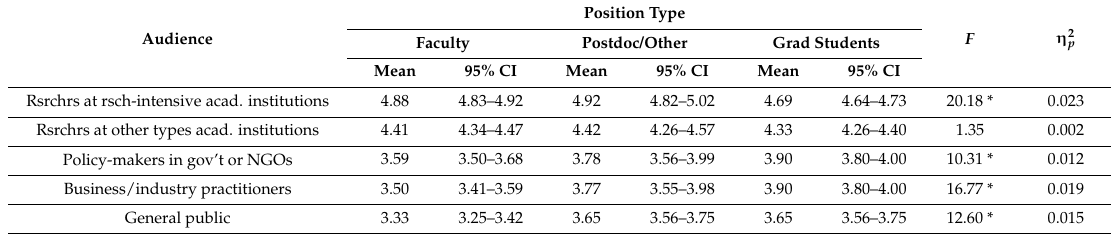
Table 11. Importance of accessibility for different audiences by